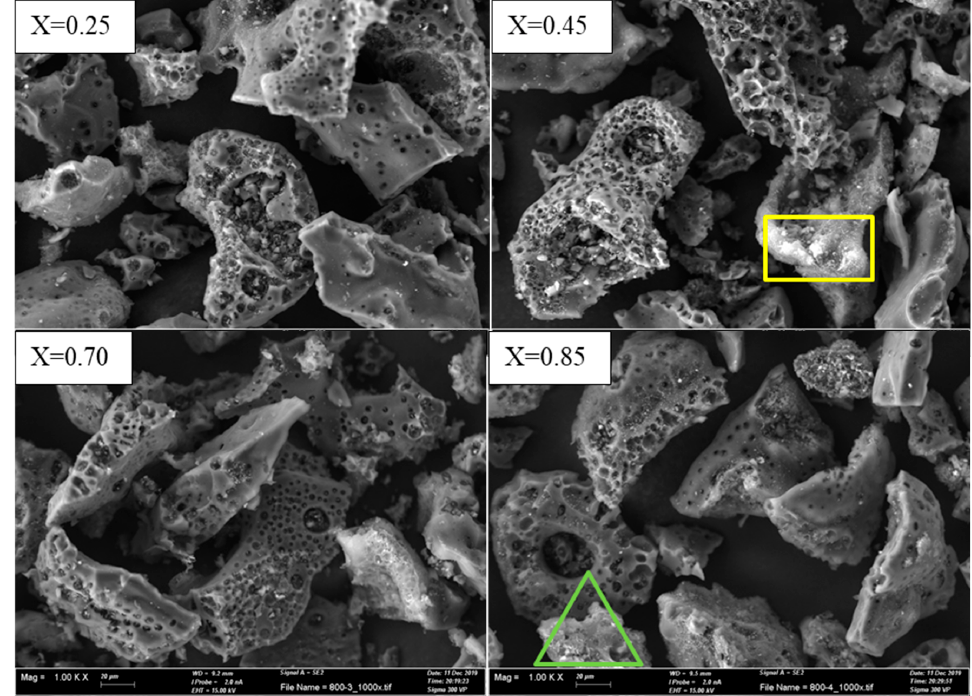
Figure 9. SEM images (1000× magnification) of char at different carbon conversions prepared from char gasification in H 2 O at 750 °C. Energies 2020 , 13 , x FOR PEER REVIEW